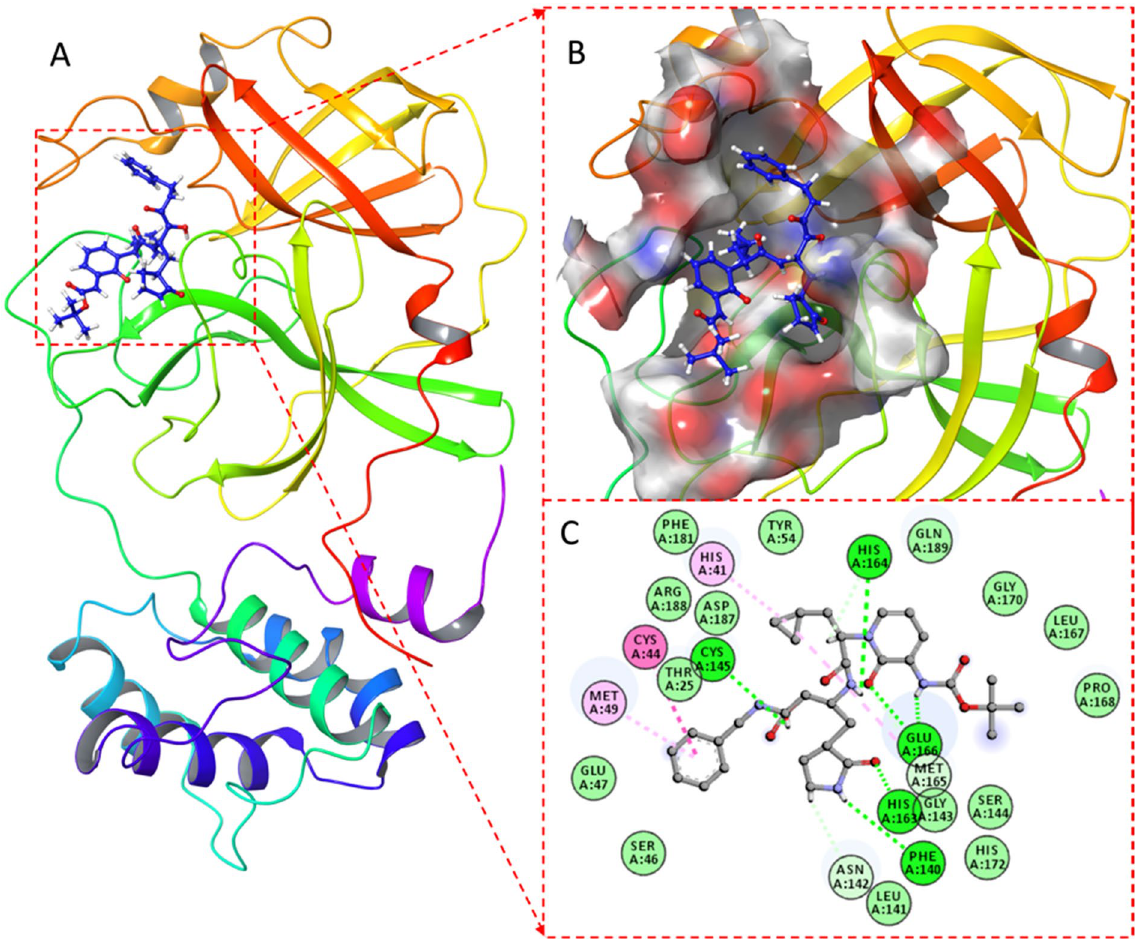
Figure 3. ( A ) αk-13b inhibitor in complex with M pro enzyme, ( B) Surface view colored by charge showing the catalytic pocket of the Mpro enzyme; ( C ) 2D representation of the interaction map of docked inhibitor in complex with M pro